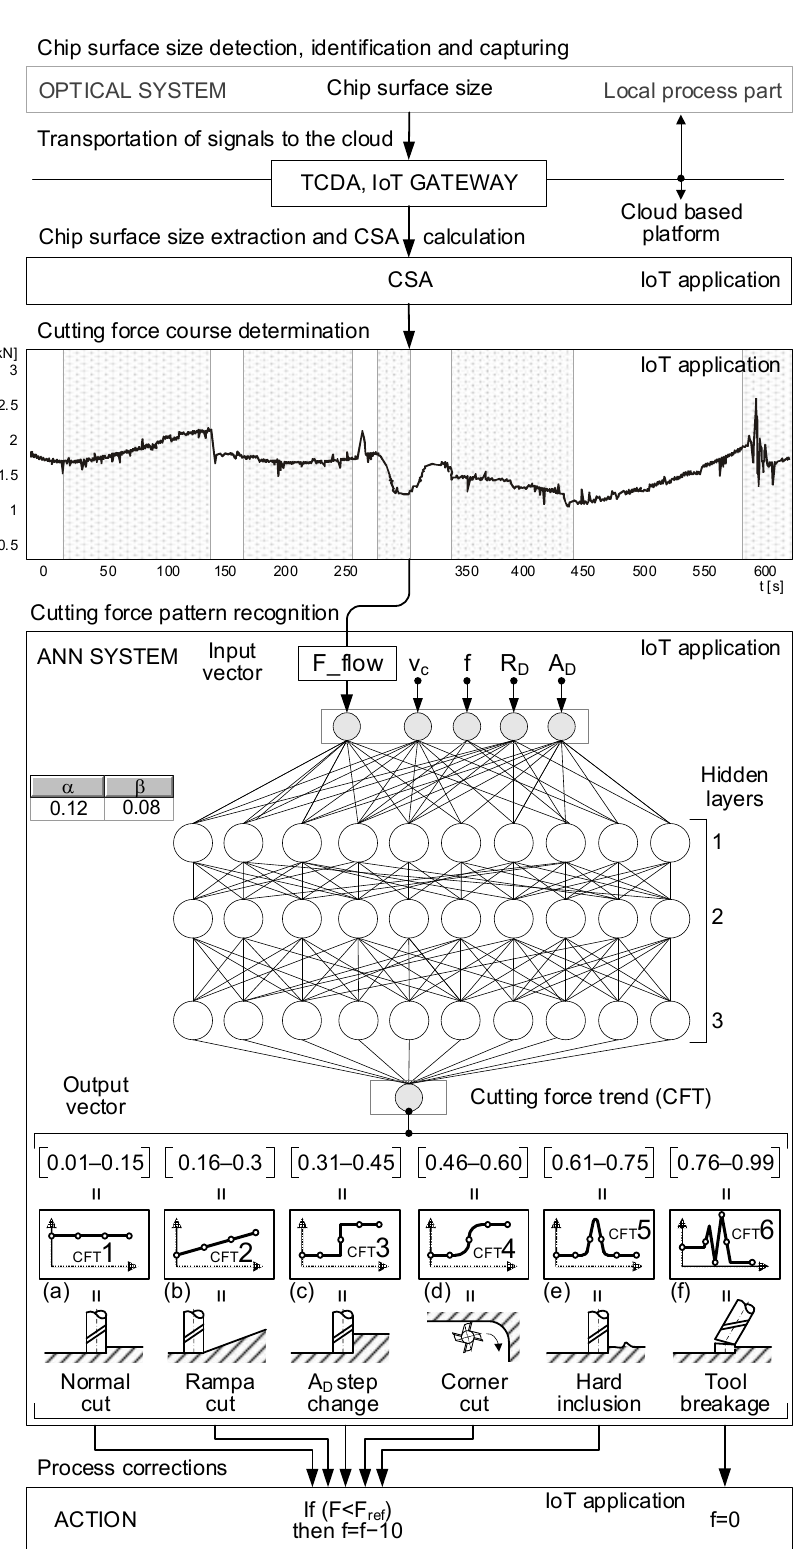
Figure 1. Algorithm of functioning of the cloud TCM with detailed structure of ANN for recognition of 6 typical cutting force patterns; normal cut ( a ), ramp cut ( b ), A D step change ( c ), corner cut ( d ), hard inclusion ( e ) and tool breakage ( f ).